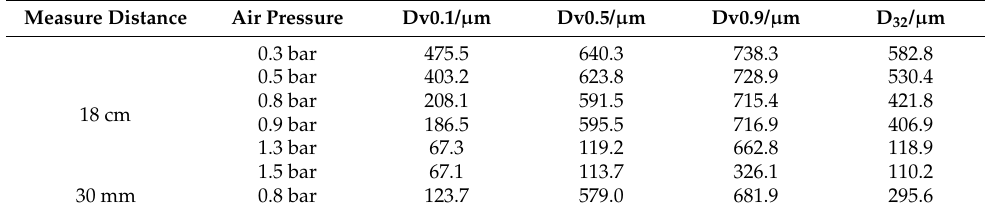
Table 3. Test results of atomization particles.